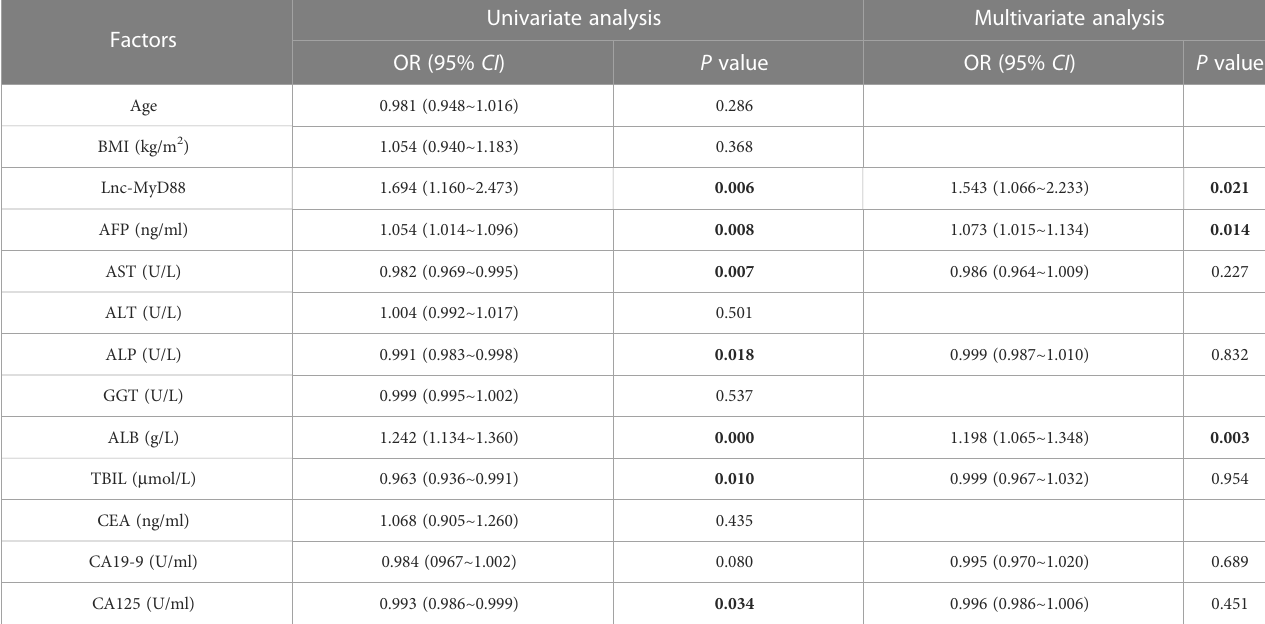
TABLE 7 The univariate and multivariate analyses indicated the diagnostic value of various clinical factors (including lnc-MyD88 and AFP) in HBV-related HCC group, and the HBV-related liver cirrhosis group is the control.